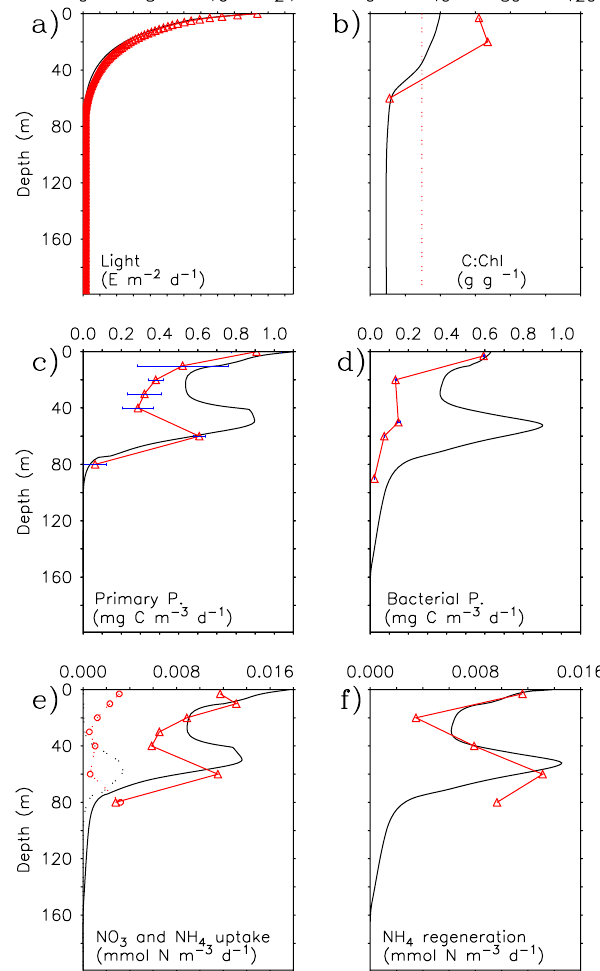
Fig. 6. Model–data comparisons (rates) for the “standard” run. Model outputs are in black and observations in red: (a) downwelling PAR, (b) C:Chl ratio (for SP in the model; for the observations de- rived from Claustre et al. (1999) (see text for details); the vertical dashed line is the mean C:Chl ratio according to DuRand et al., 2002, and Sherr et al., 2003), (c) primary production, (d) bacte- rial production, (e) NH 4 and NO 3 uptake (in the model, full and dashed lines, respectively; in the observations, triangles and circles, respectively) and (f) NH 4 regeneration. On panels (c) and (d) , the averages ± standard deviation appear in